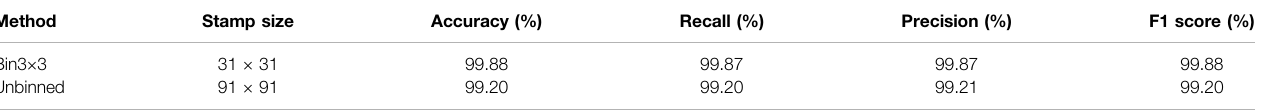
TABLE 3 | Precision of the CNN model for stamps from QIP and